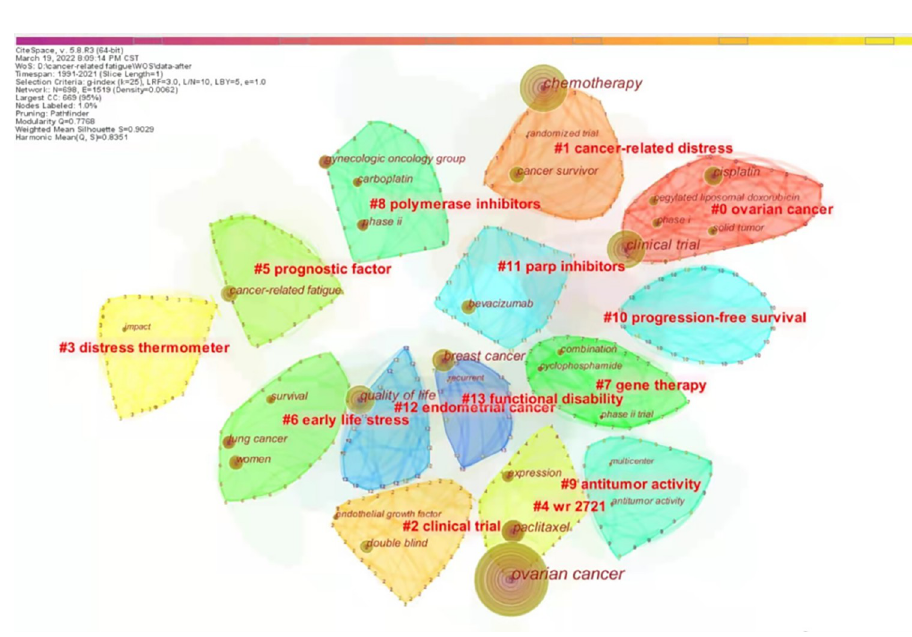
Fig 6. Map of keyword clustering in cancer-related fatigue in ovarian cancer